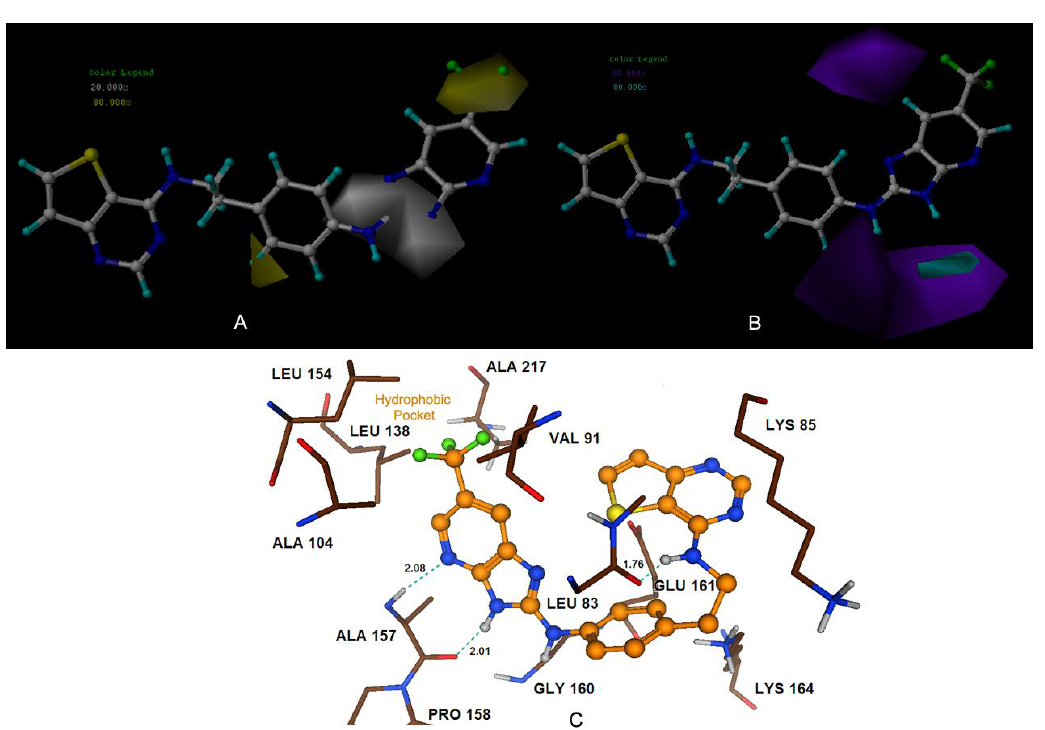
Figure 5. CoMSIA StDev*Coeff contour plots for SNS-314. ( A ) The hydrophobic contour map (yellow/white) represents respective 80% and 20% level contribution combined with compound 105. Yellow contours indicate regions where hydrophobic favorable substituents increase activity; white contours indicate regions where hydrophobic unfavorable substituents increase activity; ( B ) The hydrogen-bond donor (cyan/purple) contour map represents respective 85% and 15% level contribution combined with compound 105. Cyan contours indicate regions where hydrogen-bond-donor favorable substituents increase activity; purple contours indicate regions where hydrogen-bond-donor unfavorable substituents decrease activity; ( C ) The enlargement for stereoview of the docking structure of compound 105 in complex to the active site of the monomer structure of the Aurora B. Hydrogen bonds are shown as dotted green lines. Active site amino acid residues are represented as sticks, while the inhibitor is shown as ball and stick